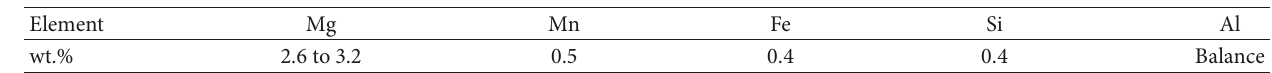
Table 2: Chemical composition of AW 5754 aluminium